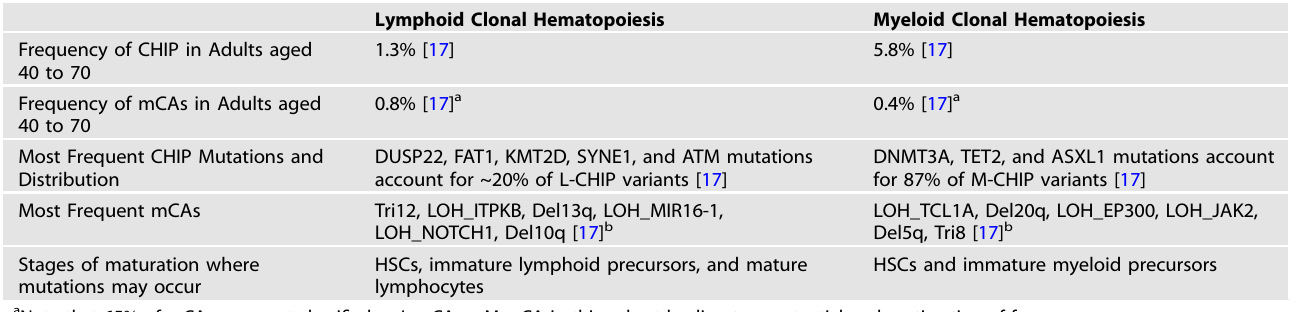
Fig. 1 M-CH and L-CH biased mutations drive distinct health outcomes. Mutations acquired in hematopoietic stem cells can provide a selective advantage, leading to the formation and expansion of an HSC clone. Often these mutations bias the production of progeny cells towards either myeloid or lymphoid lineages of cells and have distinct consequences for each lineage. In myeloid biased clonal hematopoiesis ( left ), somatic mutations are associated with an increased risk of myeloid malignancy, cardiovascular disease, and all-cause mortality. In lymphoid biased clonal hematopoiesis ( right ), somatic mutations are associated with lymphoid malignancy and late-onset forms of autoimmunity and immune de fi ciency. Table 1. Comparison of Signi fi cant Differences between L-CH and